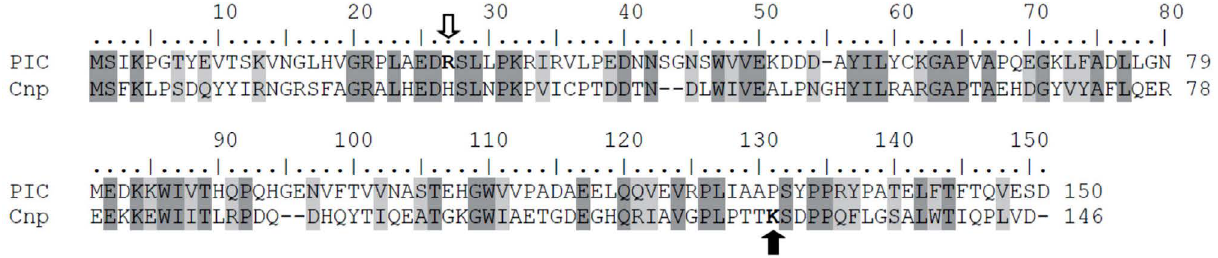
Figure 2. Alignment of deduced amino acid sequences of mycospins. Identical residues are highlighted in dark grey and similar residues in light grey. Amino acid sequences of cnispin (Cnp) and cospin (PIC) are aligned using the BLOSUM62 matrix. The arrows indicate the trypsin reactive P1 residue in cospin (white) and in cnispin